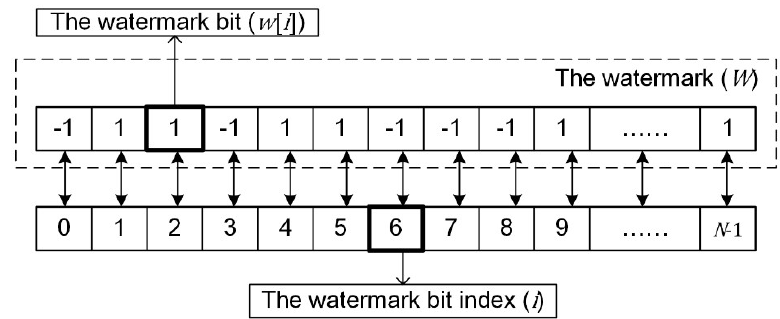
Figure 3. The relationship between the watermark, the watermark bits, and the watermark bit indices.